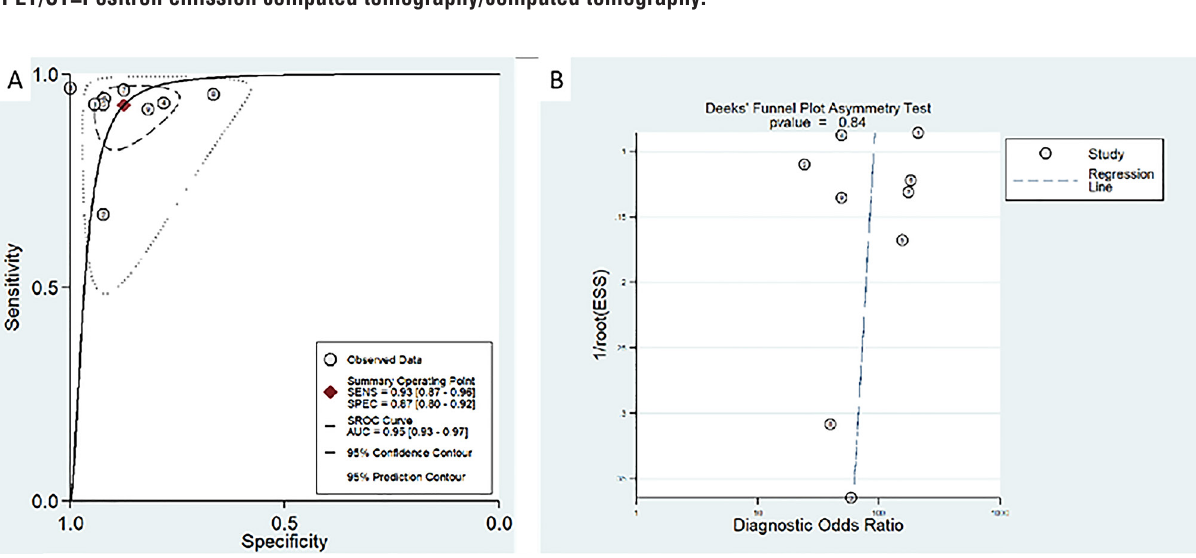
Figure 4-A) Hierarchical summary receiver operating characteristic curve for the diagnostic performance of 68Ga-PSMA PET/CT in patients with primary prostate cancer. B) Deeks’ funnel plot was used for each patient analysis. The p value was 0.44>0.05, indicating a low possibility of publication bias. ESS=effective sample size. AUC=area under the curve; SROC=summary receiver operating characteristic; 68Ga-PSMA=Gallium (68) labeled prostate-specific membrane antigen; PET/CT=Positron emission computed tomography/computed